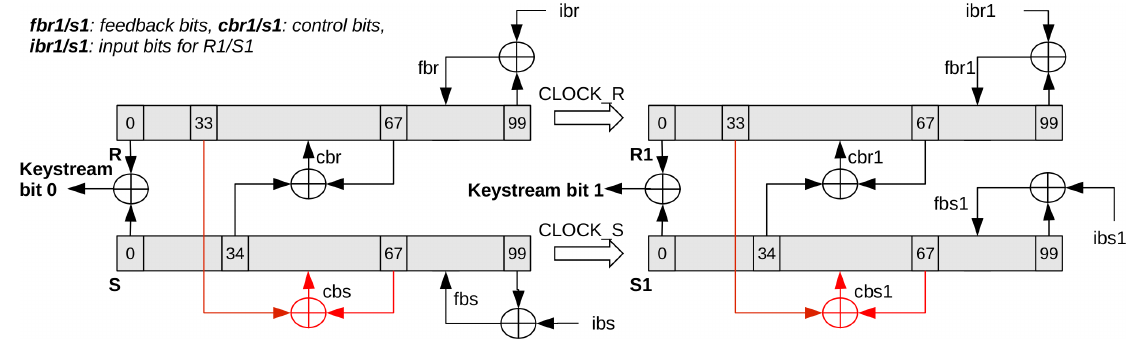
Figure 2. MICKEY 2.0 (2 × ) architecture (unrolled twice).